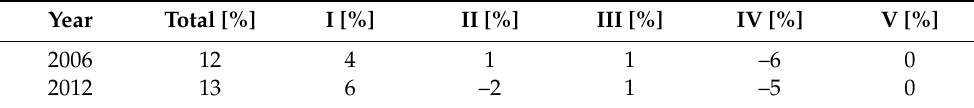
Table 12. The DI values in the CU Doln í Bˇrežany.